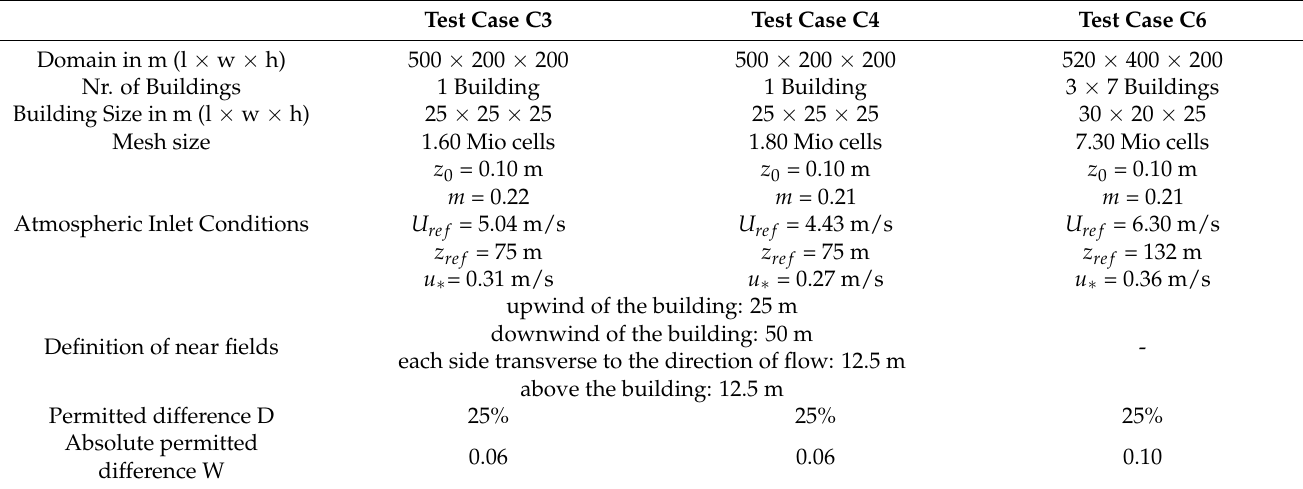
Table 1. Parameters of each test